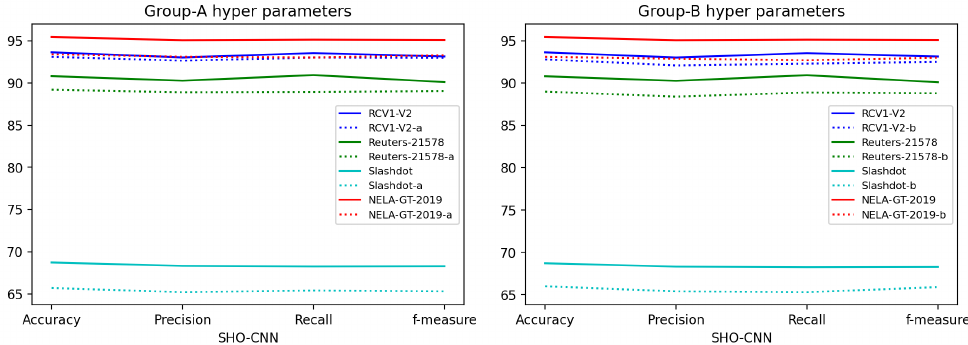
Figure 3. Comparisons based on ablation study.